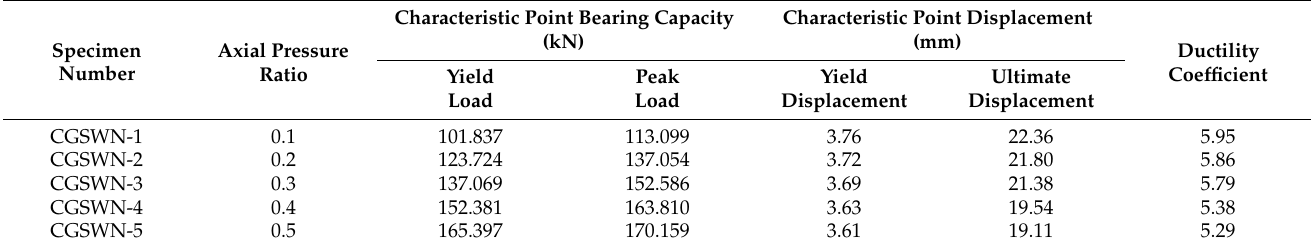
Figure 19. The skeleton curve of the specimen under different axial pressure ratios. Table 11. The characteristic point parameters of the specimen under different axial pressure ratios.